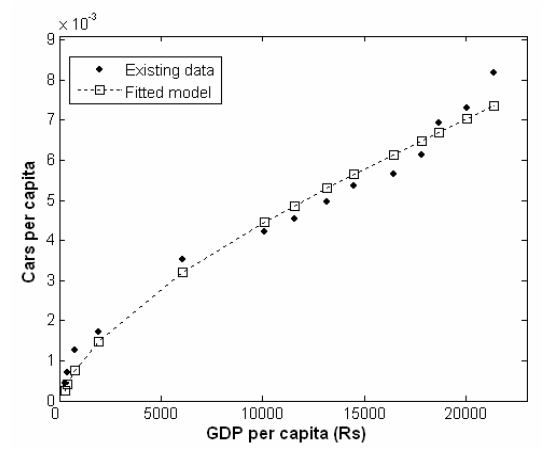
Fig 9. Estimates of the fitted model